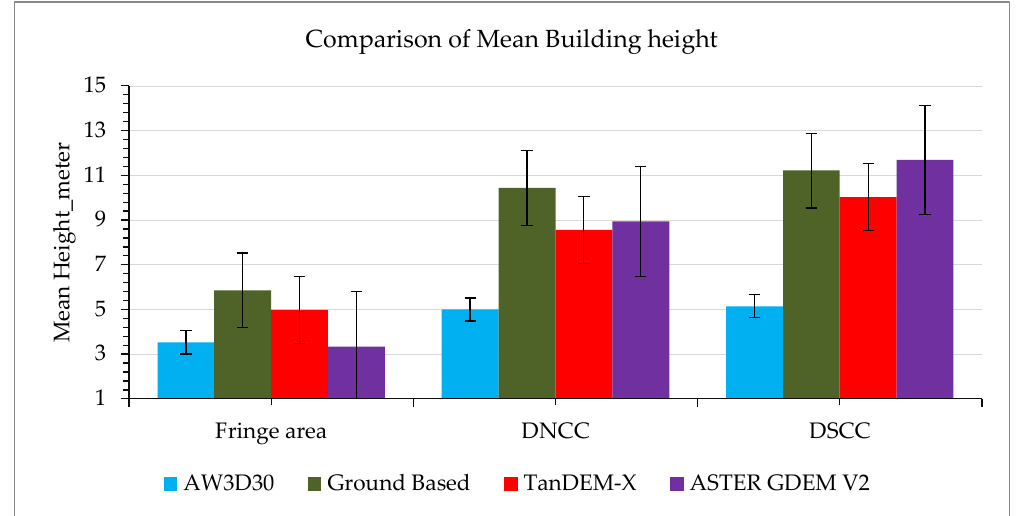
Figure 10. Mean vertical growth of DMA. The Y-axis shows building height by meter and the X-axis shows three zones of the study area.